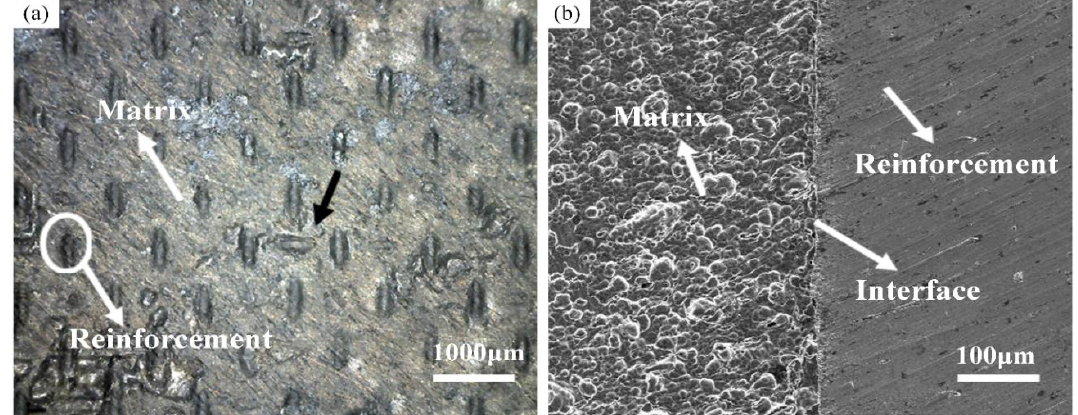
Figure 4. SEM micrograph of MIMC composites: ( a ) the surface microstructure; ( b ) cross-section of reinforcement with matrix.